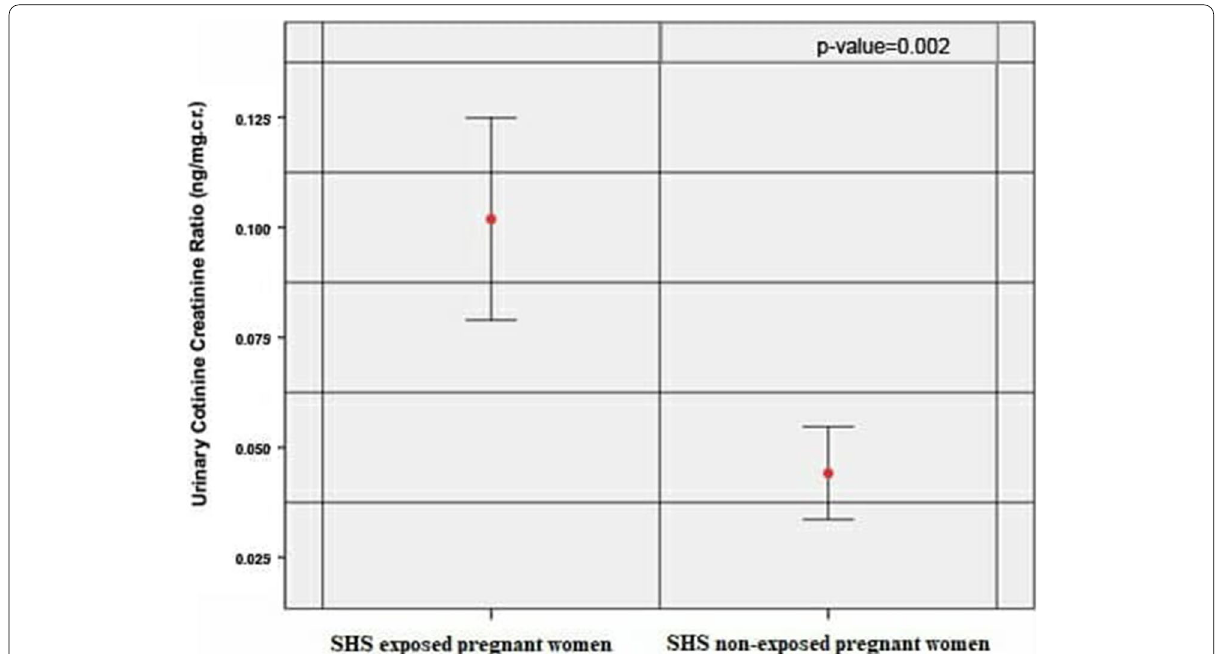
Fig. 1 Urinary cotinine creatinine ratio in the studied population: urinary cotinine creatinine ratio was significantly higher in pregnant women exposed to SHS compared to non-exposed pregnant women. The mean value as well as the mean rank of CCR was significantly higher (0.1 0.08 ng/mg.cr., 40.3 respectively in the exposed pregnant women as compared to the non-exposed pregnant women (0.04 ± respectively, p value<